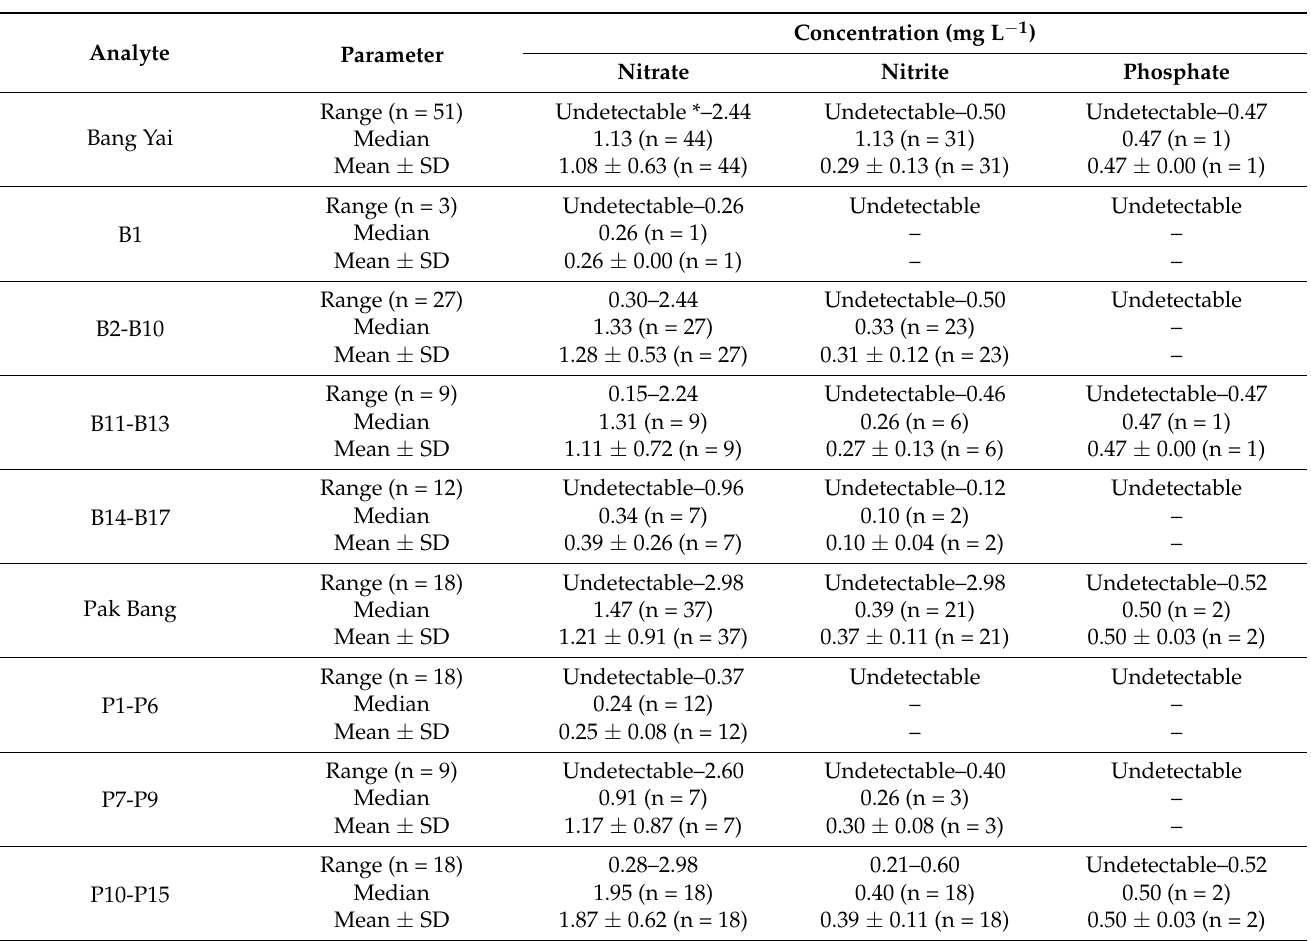
Table 5. Quantification of nutrients in water samples in Phuket, Thailand, using the developed in-tube hydrogel test kits and on-mobile